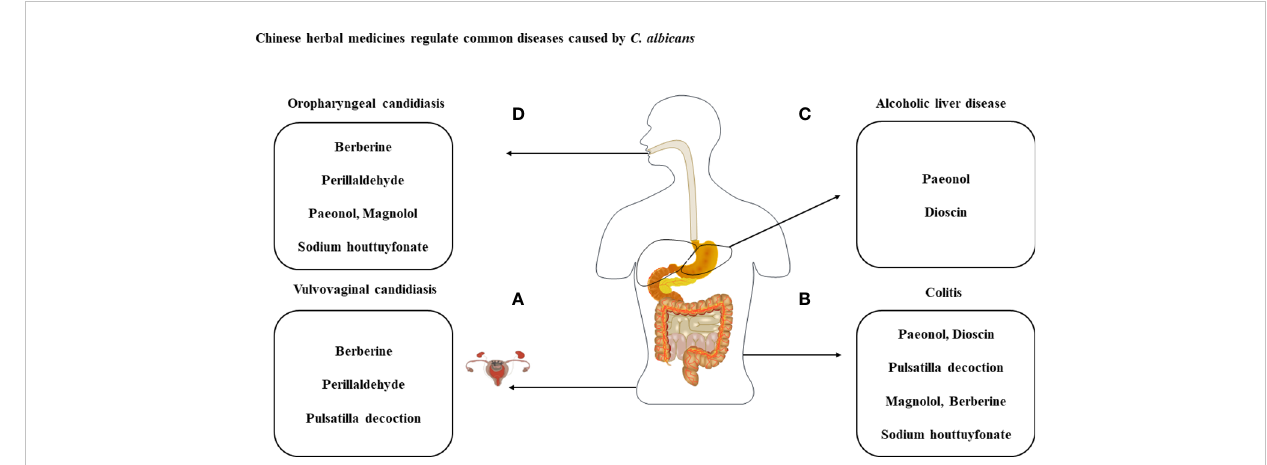
FIGURE 3 Treatment of diseases caused by C albicans with the listed compounds. (A) Perillaldehyde, pulsatilla decoction and berberine have antimicrobial effect against C albicans and treat VVC through cytokines produced by immune cells. (B) With the exception of perillaldehyde, the above-mentioned compounds have therapeutic effects on C albicans and DSS-induced colitis. (C) Dysbiosis of the intestinal fl ora caused by C albicans can exacerbate ALD and can be treated with paeonol and dioscin. (D) Therapeutic studies of berberine, perillaldehyde, paeonol, magnolol and sodium houttuyfonate against